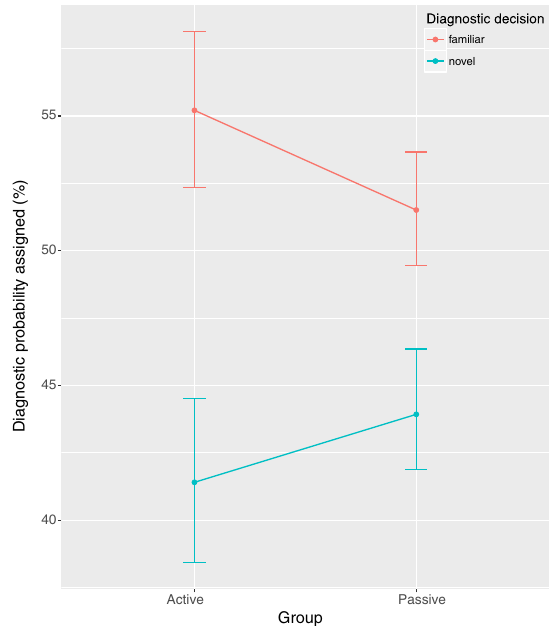
Fig. 2 Mean diagnostic probabilities assigned (%) to the diagnosis supported by familiar symptom descriptions (reference to practice case vignettes; red) versus the diagnosis supported by novel symptom descriptions (blue) from Experiment 1. The mean diagnostic probabilities assigned to the other two of the four diagnostic options (i.e., those not intended to be represented in the case vignette) were collected but are not displayed here. Data are presented for each test group (active retrieval, passive rehearsal). Error bars represent bootstrapped 95% confidence